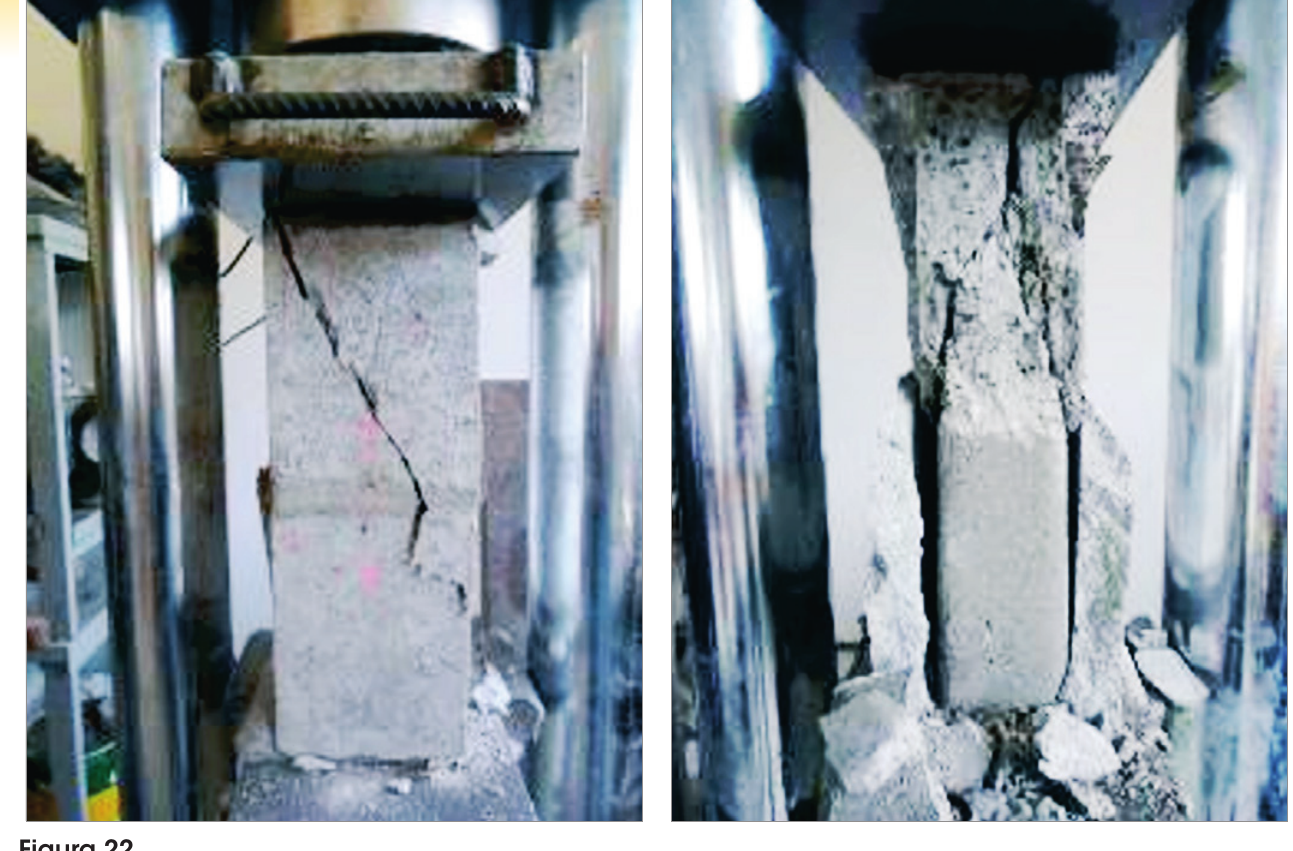
Figura 22 Ilustração dos ensaios prismas ocos e grauteados Tabela 10 Resistências à compressão média dos blocos, B Designação